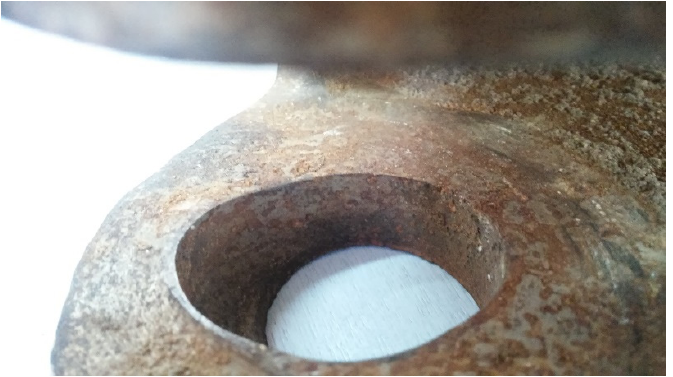
Figure 4. A view on the measured region of the wear-caused dimensional deviations of the in- spected parts.